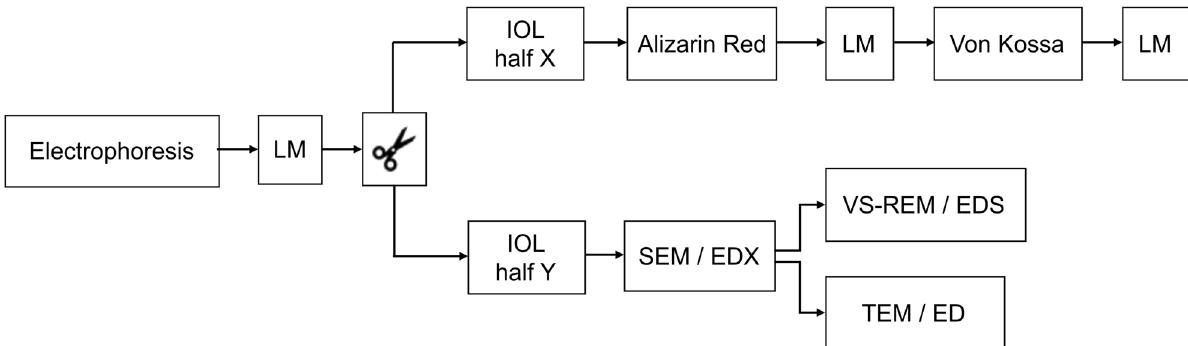
Figure 2. Analysis methods. After electrophoresis, light microscopy (LM) images were taken of the complete IOLs. Then the IOLs were bisected into X and Y halves. The X half was analyzed using the Alizarin Red and the Von Kossa methods. The anterior and posterior surfaces of the Y half and vertical sections (VS) of these Y halves were investigated using scanning electron microscopy (SEM), energy dispersive X-ray spectroscopy (EDX), transmission electron microscopy (TEM) and electron diffraction